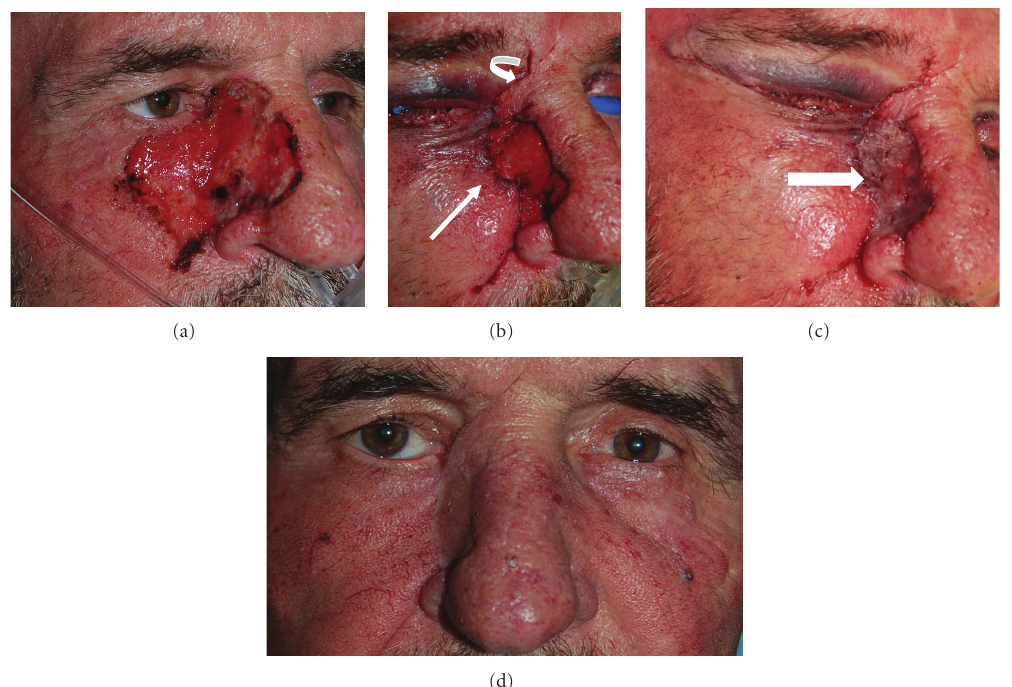
Figure 3: (a) a 65-year-old male status after Moh’s resection for lentigo maligna melanoma in the right lower lid, cheek, and lateral nasal wall. The defect measured 5cm by 4cm. (b) It was decided to decrease the size of the defect using adjacent tissue flaps prior to considering use of a skin graft. Alternatively, a skin graft could be placed for the entire defect; however, it is our preference to use adjacent tissue whenever possible. An infraciliary incision with nasolabial extensions allows for the lateral midface and cheek to be rotated medially and superiorly to fill approximately 60% of the wound (straight arrow). In addition, this keeps the tension horizontal rather than vertical. A rhomboid flap is raised superiorly and rotated inferiorly to fill in the superior aspect of the wound (curved arrow). (c) A full thickness skin graft from the inner upper arm is used to fill in the remaining wound (arrow). (d) Eleven months postoperatively showing mild residual ectropion of right lower lid.